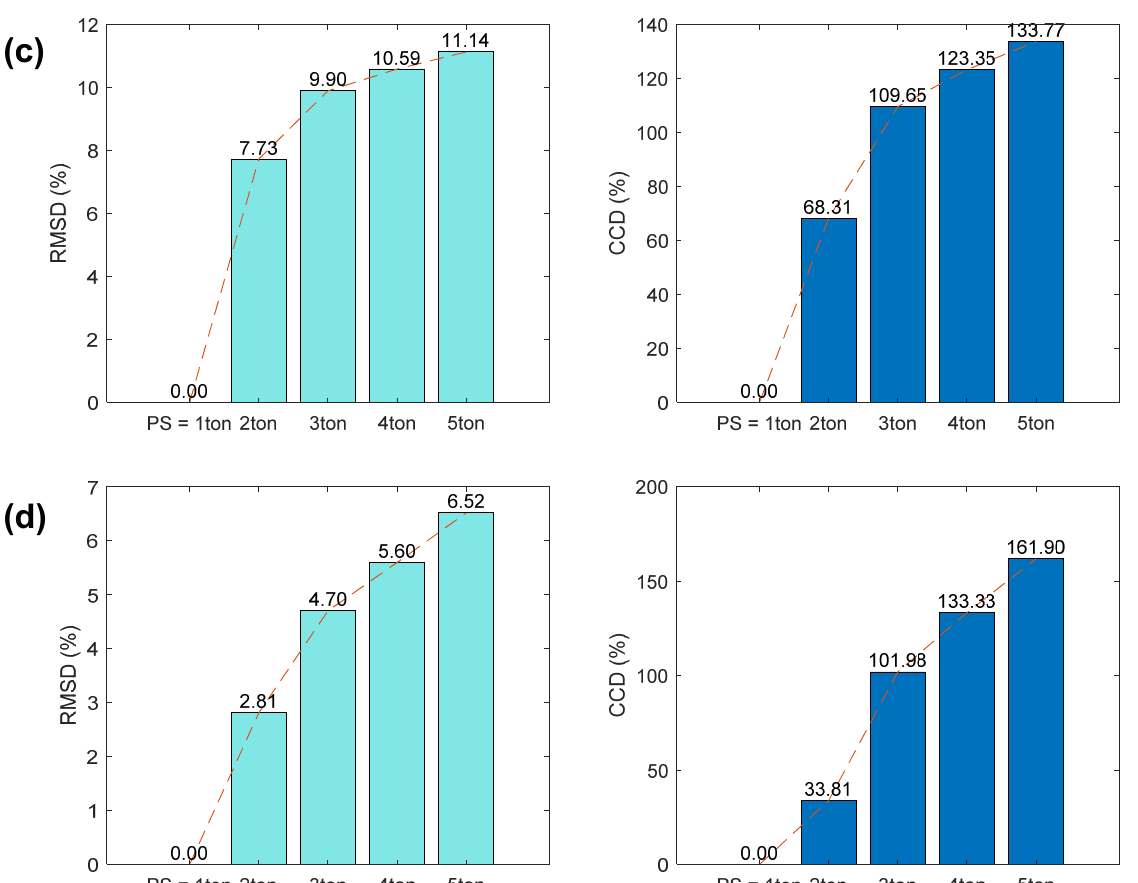
Figure 10. Changes in EMI features of the resonant bands ( a ) Peak 1; ( b ) Peak 2; ( c ) Peak 3; ( d ) Peak 4